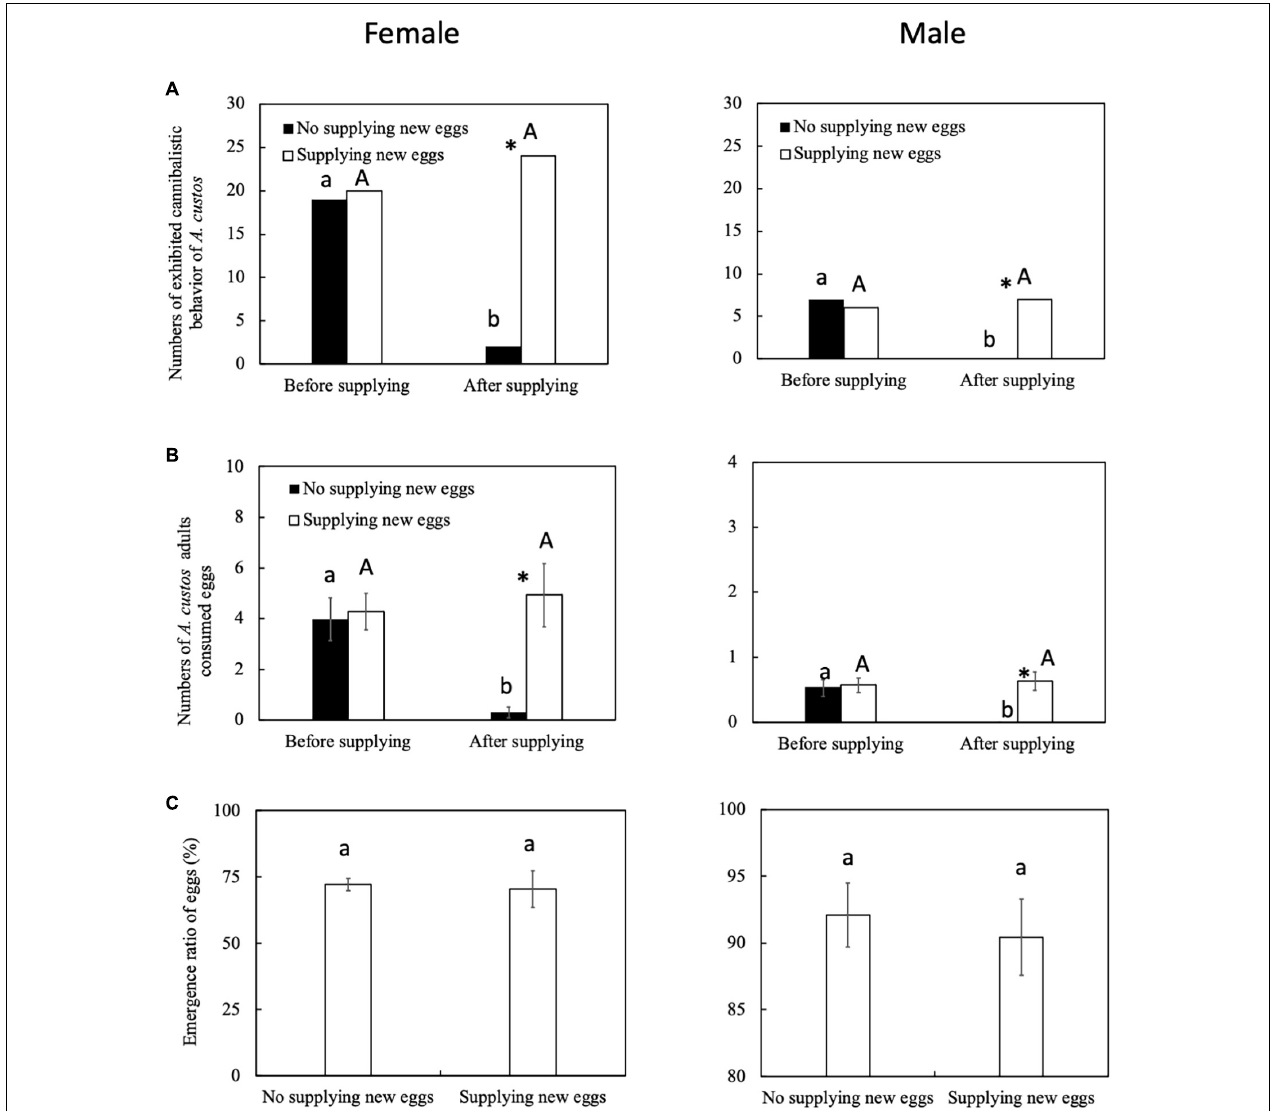
FIGURE 3 | (A–C) Predatory behavior by A. custos when supplied new eggs. Different lowercase or uppercase letters indicate a significant difference of different treatments at P < 0.05. The investigation was repeated 30 times. * indicates a significant difference between the black bar (not supplied new eggs) and white bar (supplied new eggs) at p <